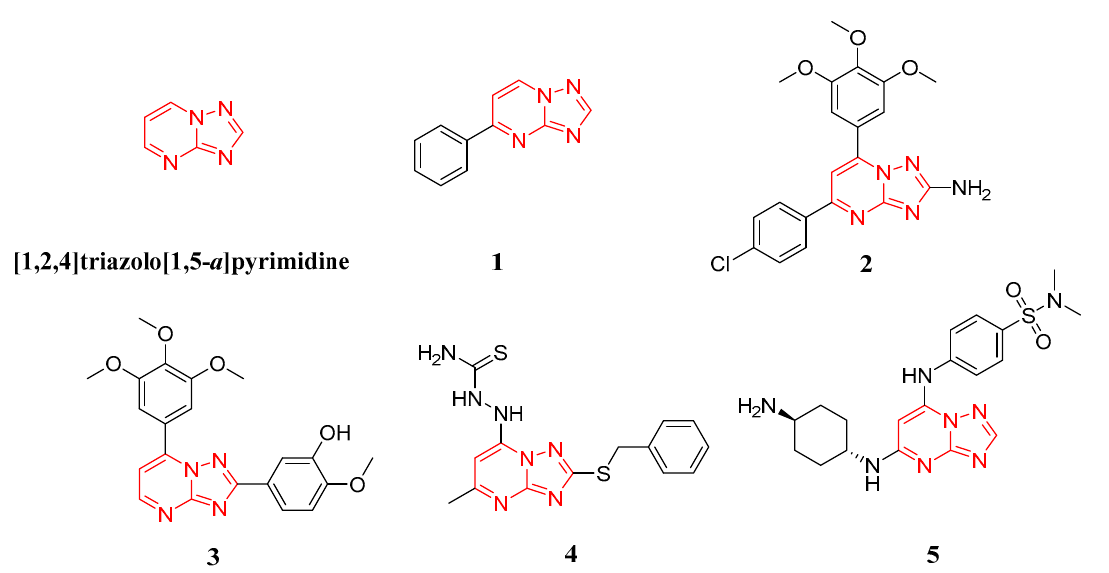
Figure 1. Structures of [1,2,4]triazolo[1,5- a ]pyrimidine and its derivates as anticancer